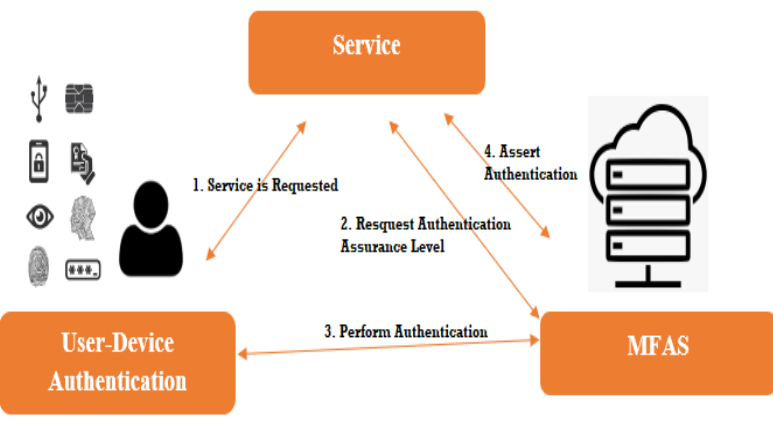
Figure 4. Basic Architecture of MFA system.